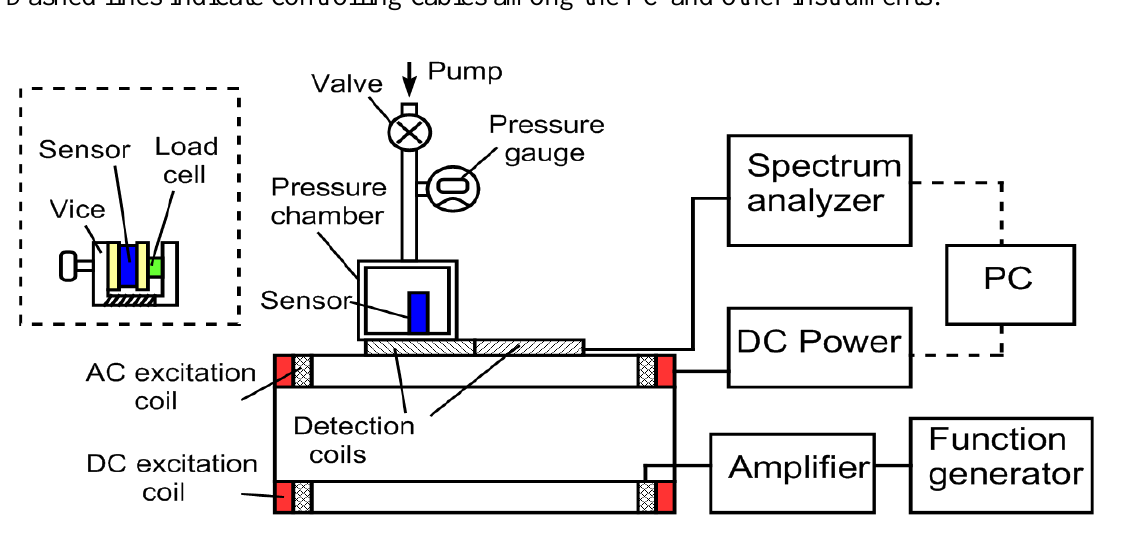
Figure 3. The experimental setup showing the remote interrogation of the pressure sensor. The cutoff on the left side of the figure shows the setup for stress/strain measurements. Dashed lines indicate controlling cables among the PC and other